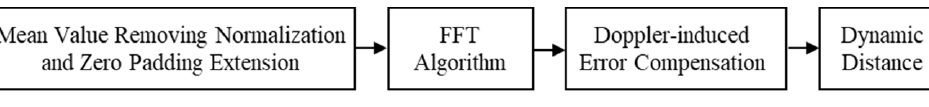
Figure 8. Data processing flow.